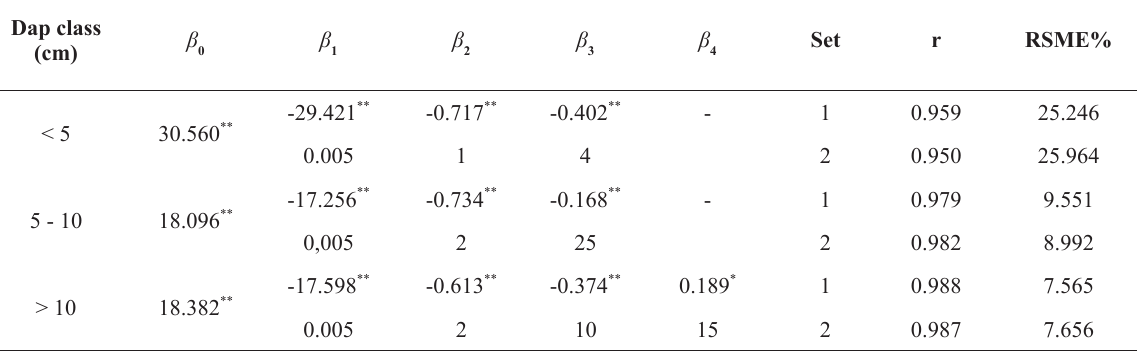
Coefficients, exponents selected by stepwise and statistical indicators of taper functions fitted by dap